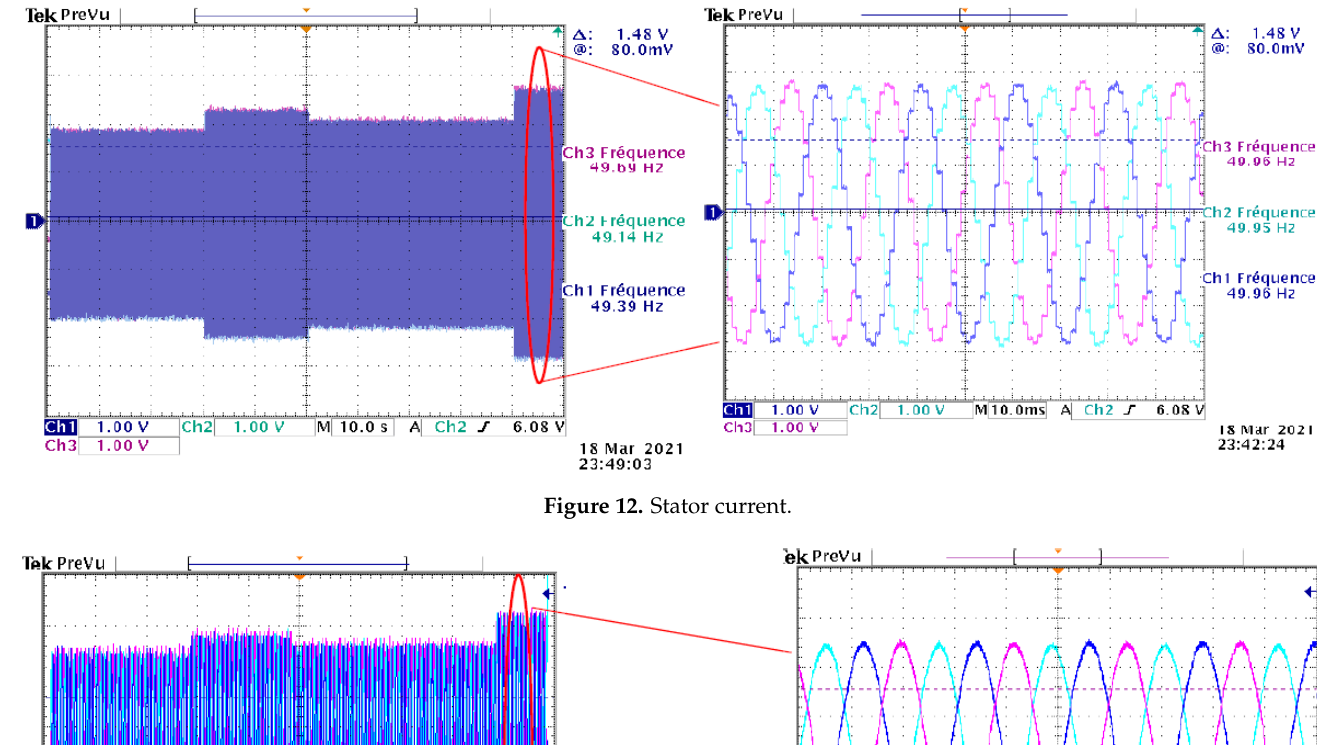
Figure 11. Direct and quadrature rotor current.